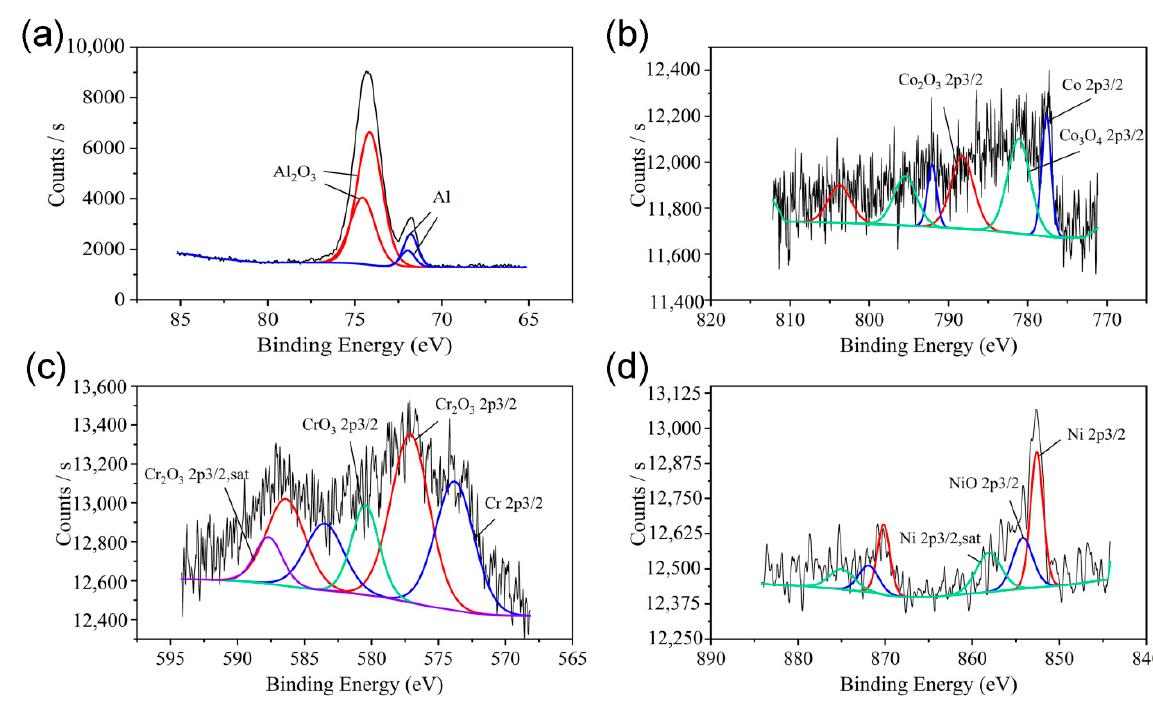
Figure 11. XPS spectra of the worn surfaces of the 5 wt.% CrCoNi/Al composite. ( a ) Al 2p, ( b ) Co 2p, ( c ) Cr 2p, and ( d ) Ni 2p.